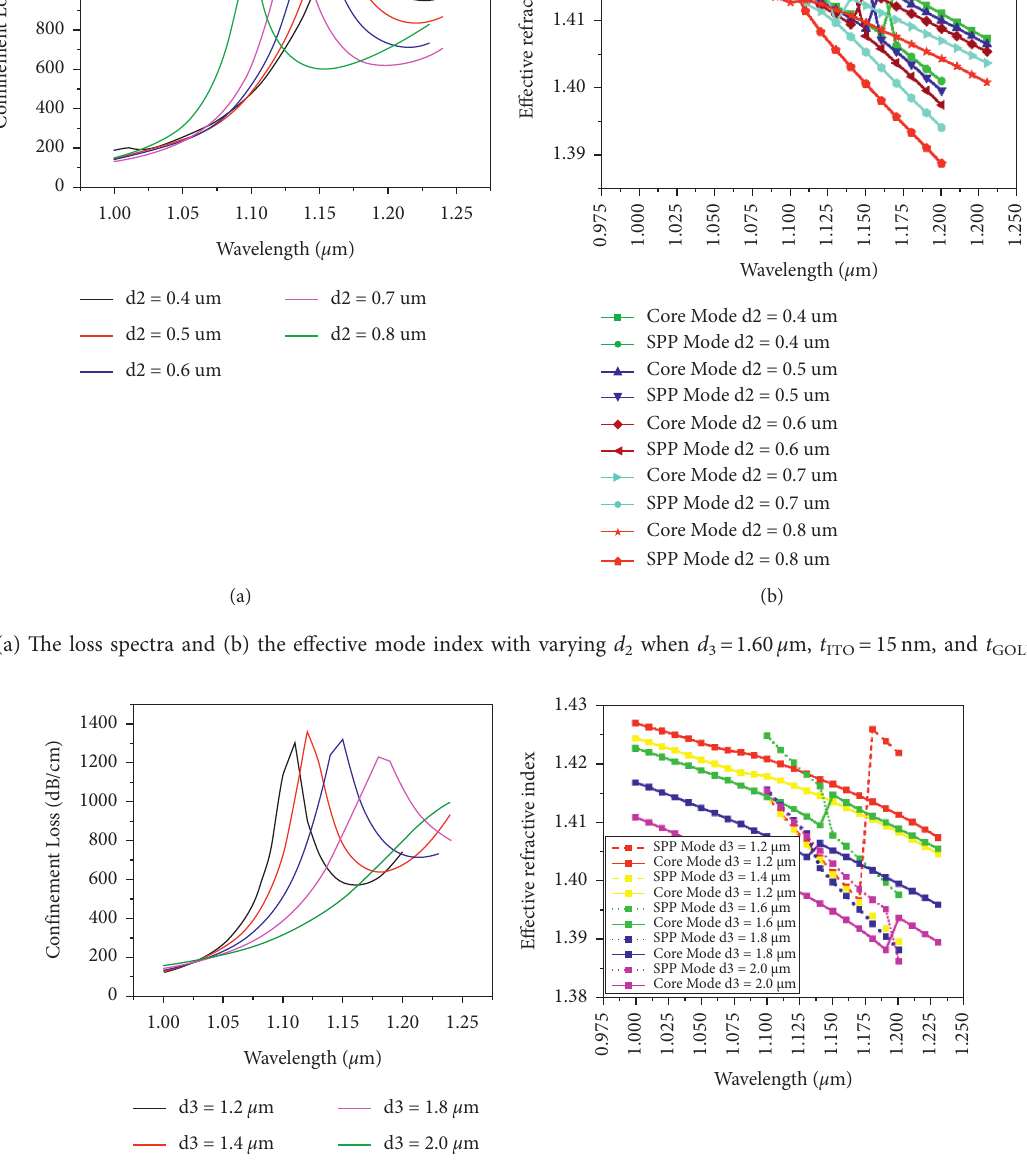
� 3.0 μ m, t � 15nm, and 3 when d 2 ITO